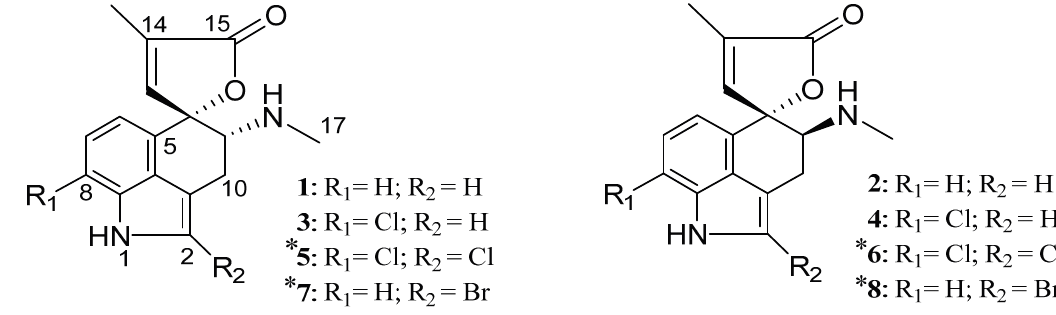
Figure 1. Chemical structures of the alkaloids produced by the T. wortmannii : ( 1 ) rugulovasine A; ( 2 ) rugulovasine B, ( 3 ) 8-chlororugulovasine A; ( 4 ) 8-chlororugulovasine B; ( 5 ) 2,8-dichlororugulovasine A; ( 6 ) 2,8-dichlororugulovasine B; ( 7 ) 2-bromorugulovasine A; and ( 8 ) 2-bromorugulovasine B. * Alkaloids reported for the first time. The depicted structures represent only relative